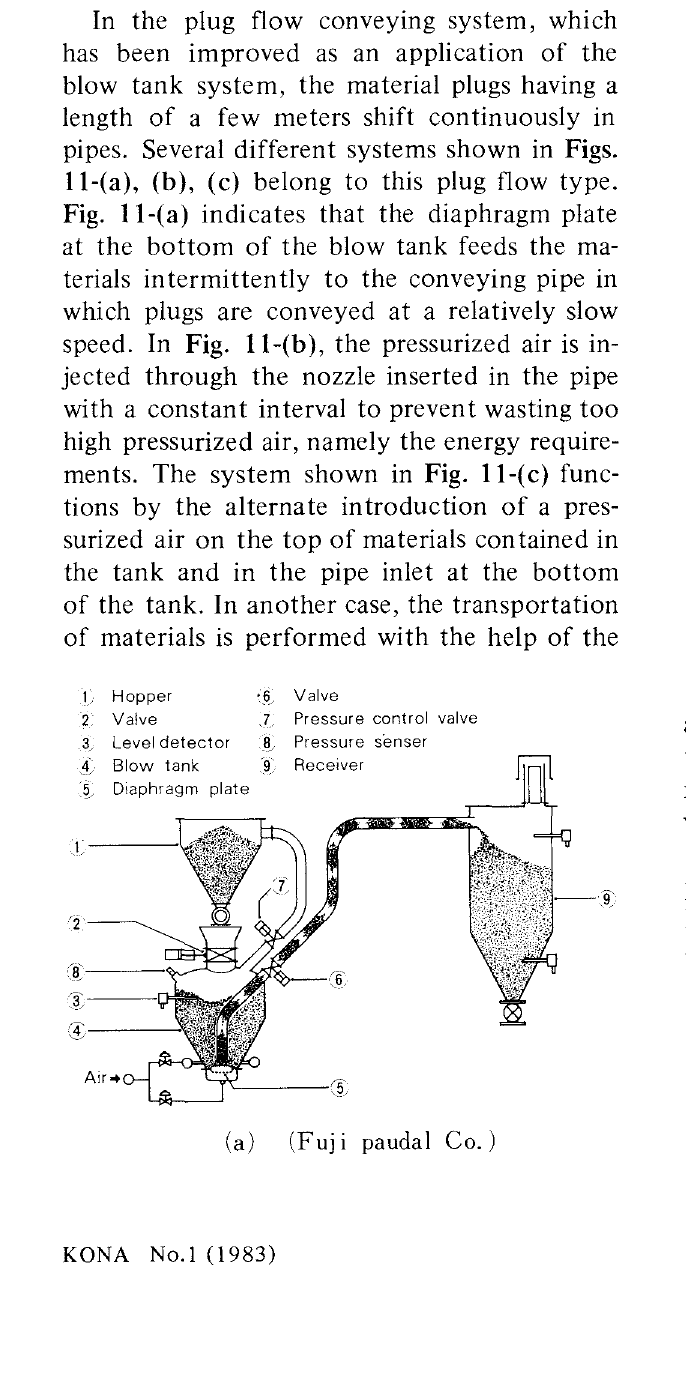
Fig. II Schematic diagrams of plug flow systems